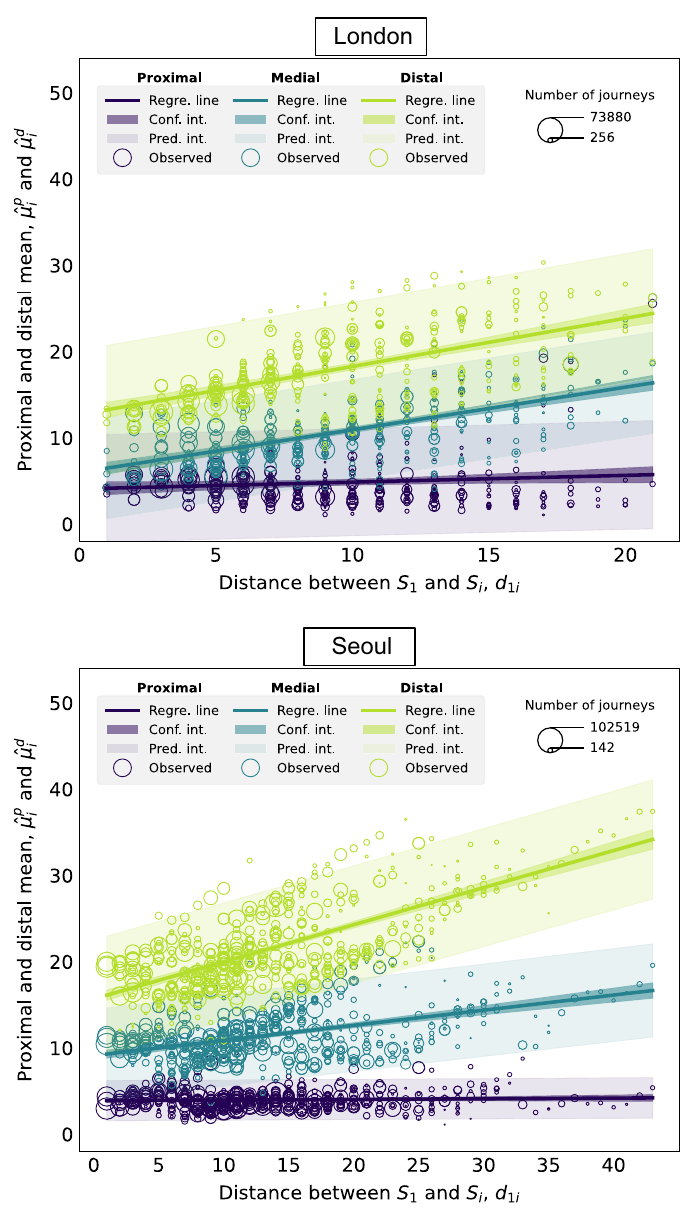
Figure 5. Relationship between the proximal, medial and distal mean of the distribution of journeys terminating at each station, ˆ µ station S